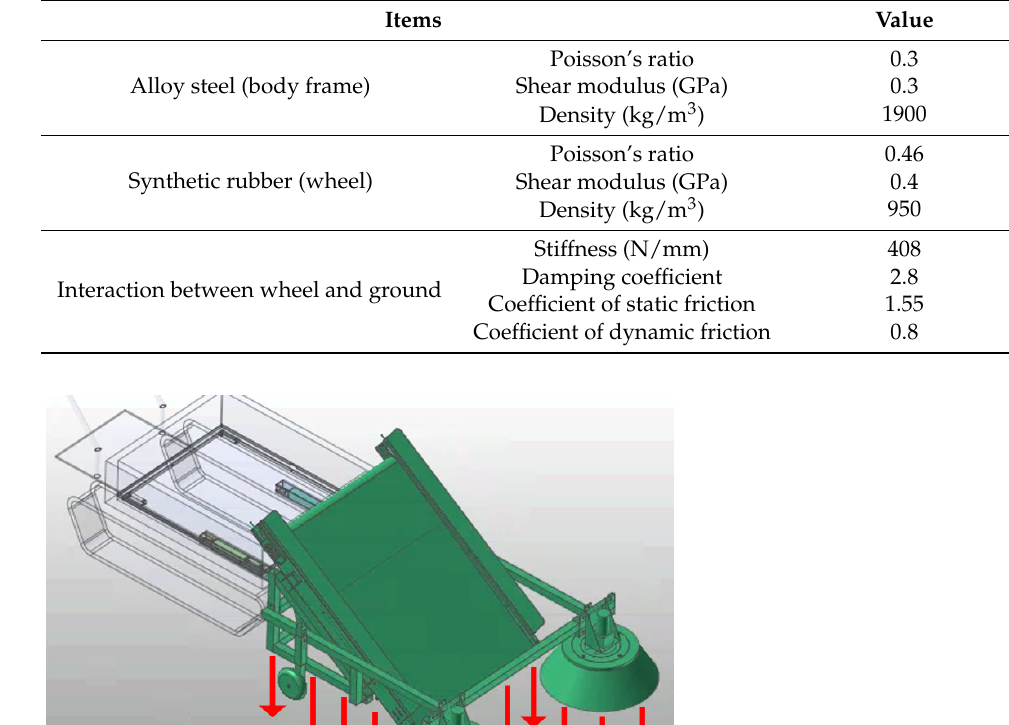
Figure 3. 3D modeling of agricultural by-product collector. Table 1. Material properties for simulation.